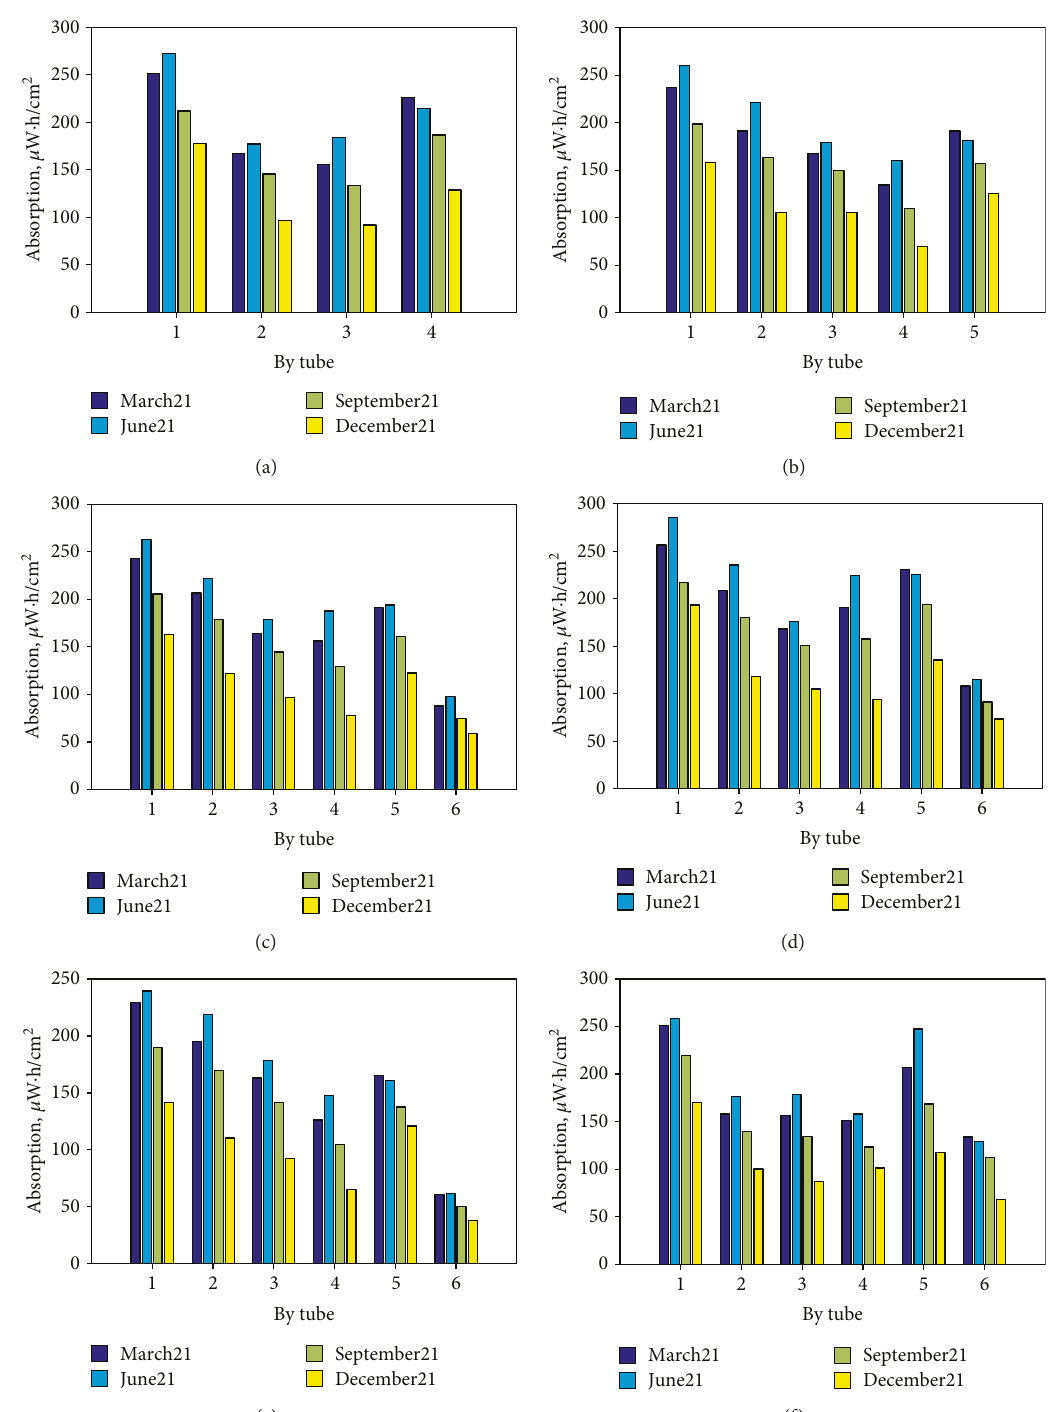
Figure 9: Average energy absorption for the solstices and equinoxes, for each tube in the di ff erent con fi gurations. Panels (a) to (f) correspond to cases 1 to 6,